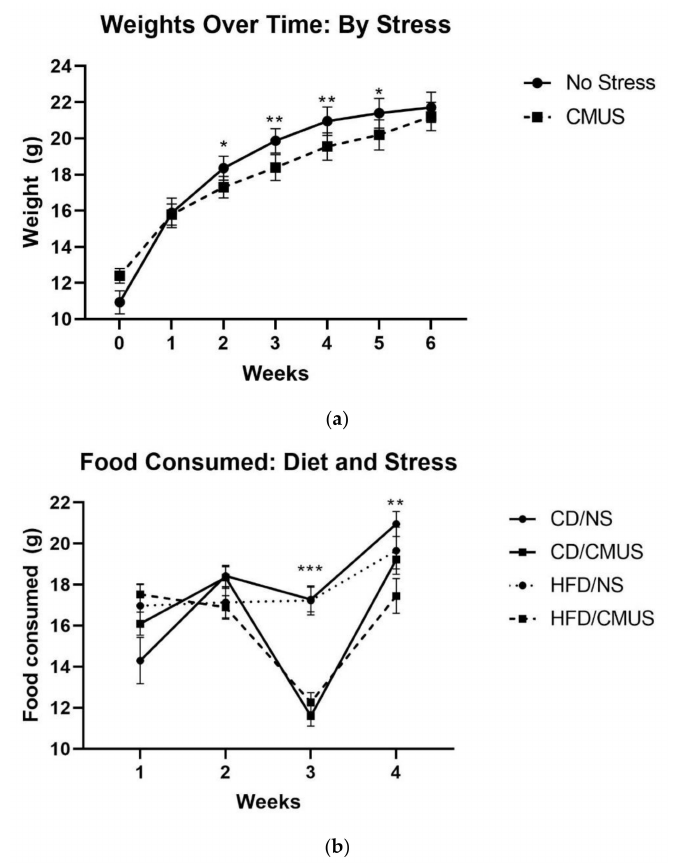
Figure 2. ( a ) Weights over time by stress. Mice experiencing NS weighed significantly more than those in the chronic mild unpredictable stress (CMUS) condition on weeks 2–5 (* p < 0.05, ** p < 0.01). Week 0 represents the start of experimental conditions (baseline—PND 28). Week 5 and 6 represents the period of behavioral testing (no CMUS occurred during this time). ( b ) Food weights over time by experimental group. CMUS was administered to half of the experimental animals for 4 weeks. Mice experiencing CMUS ate significantly less food than NS mice on weeks 3 and 4 (** p < 0.01, *** p < 0.001). Due to group housing, food consumed (g) for each animal was calculated as an